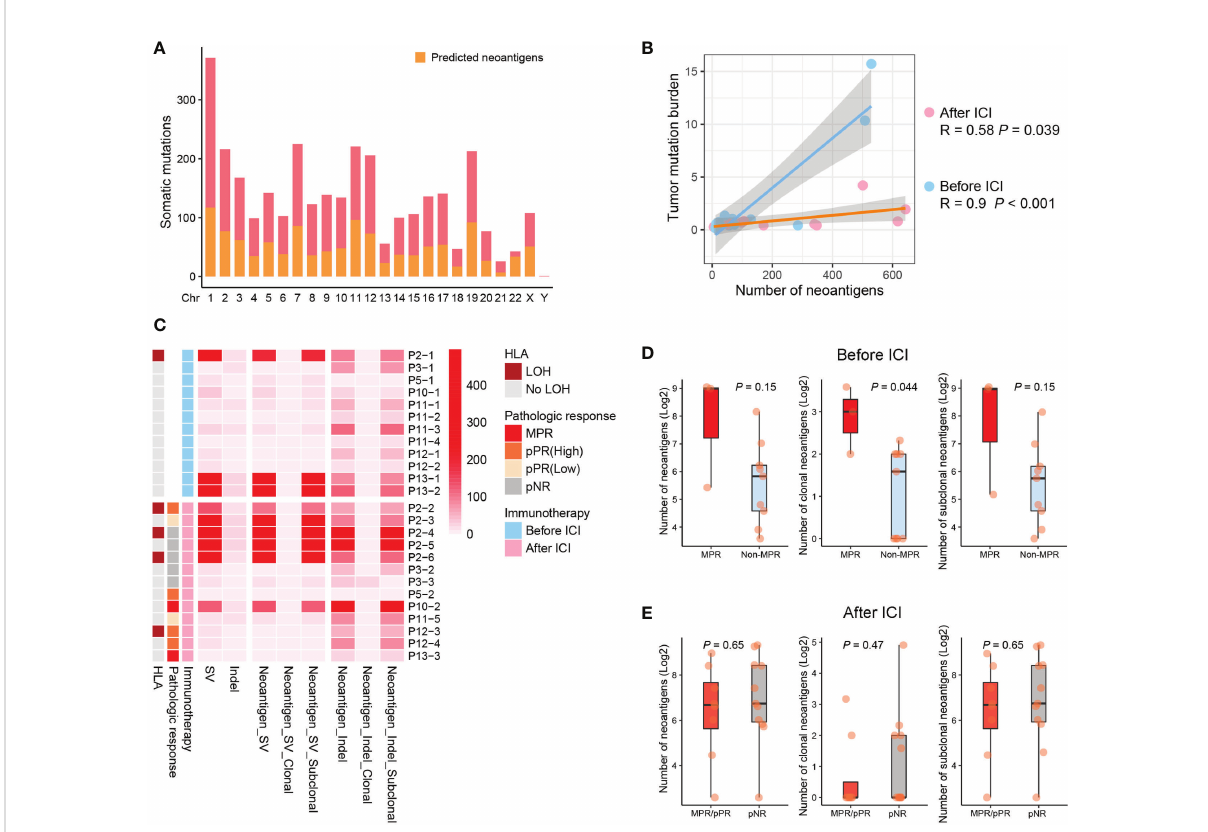
FIGURE 5 Clonal neoantigens correlates with immune responses. (A) Predicted neoantigens of identi fi ed somatic mutations in this study (See Methods). (B) Association between neoantigens and TMB for GGOs before and after ICI treatments. (C) For all analyzed GGOs, the clonal and subclonal neoantigen burden are suggested, as well as LOH events of HLA alleles and corresponding pathologic responses. (D, E) More clonal neoantigens were observed for GGOs with MPR before immunotherapy (D) , but no signi fi cant differences were indicated after ICI treatments (E)